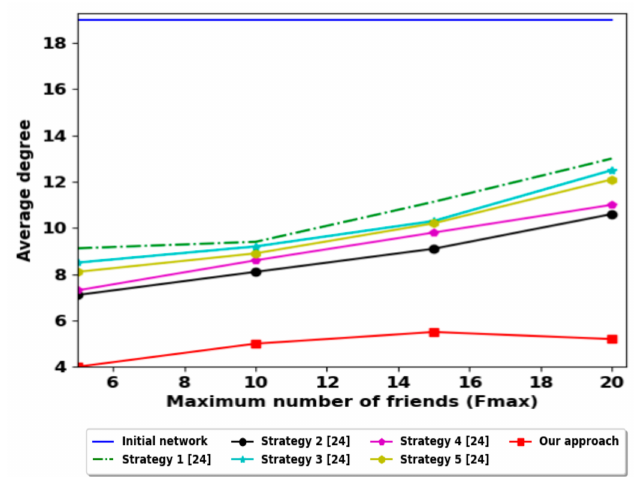
Figure 8. The average degree comparison with other strategies.